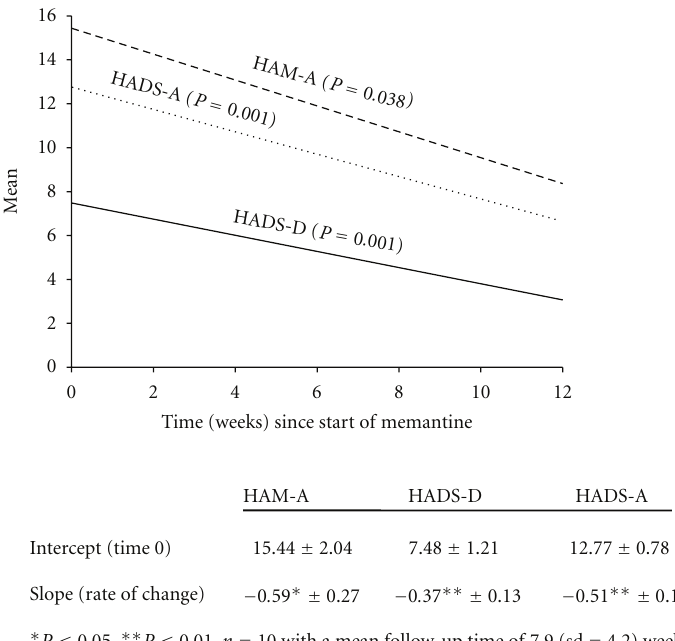
Figure 1: Mean outcome trajectories were assessed by implementing a random intercept model to account for the within-subject dependency due to repeated assessments over a twelve-week study